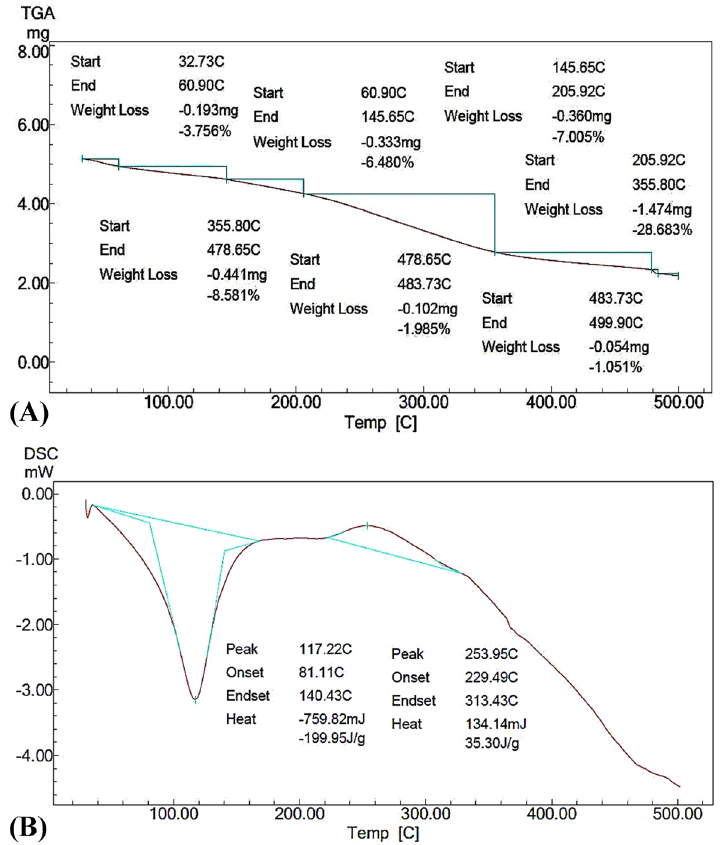
Figure 9. Chromatograms of TGA ( A ) and DSC ( B ) investigation of CNPs fabricated using Streptomyces microflavus strain